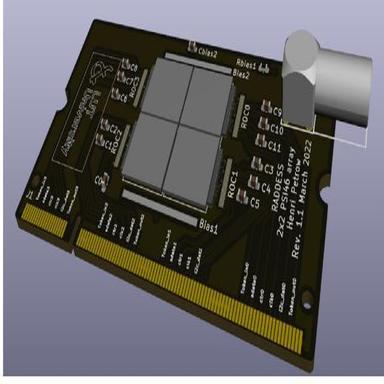
Design of the PSI46 quad board, which will be able to host four pixel detectors tiled in a two by two array.